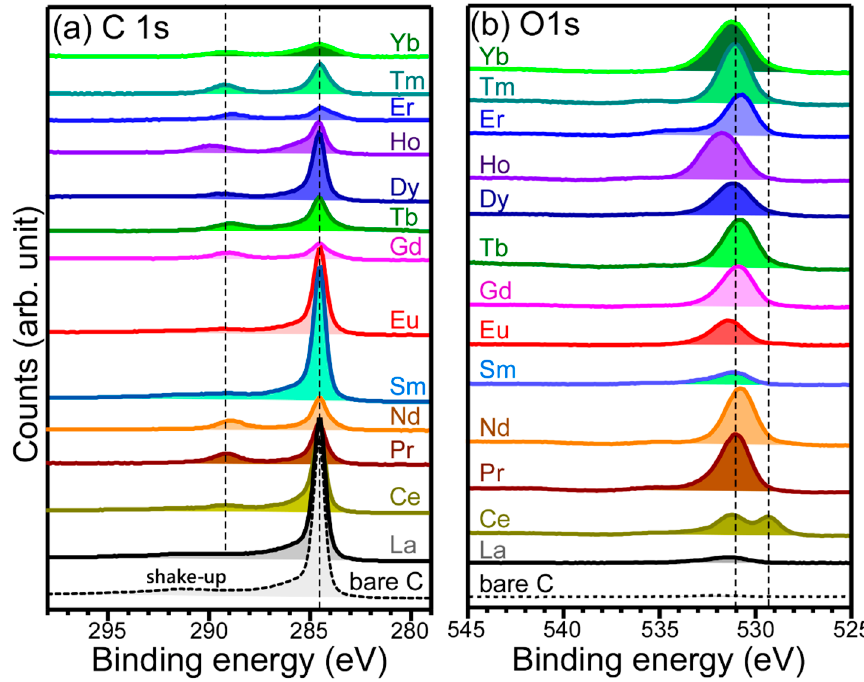
Figure 6. C 1s ( a ) and O 1s ( b ) XPS profiles for a bare carbon sheet and electrodeposited Ln elements on carbon sheets.